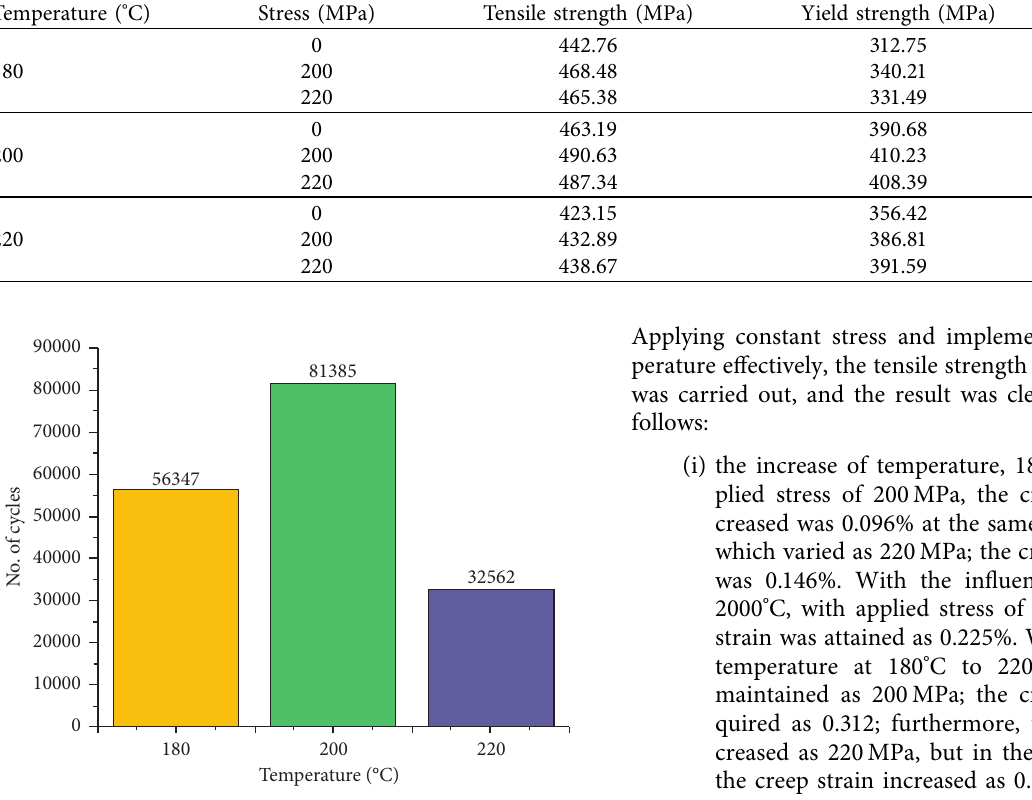
Figure 5: Fatigue analysis of the alloy with constant load after creep aging of 15hrs.